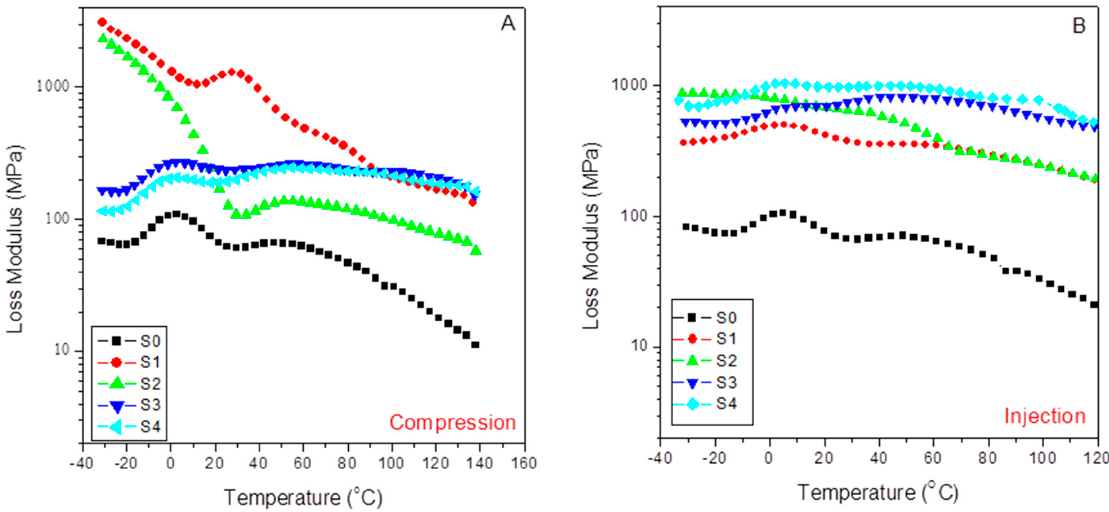
Figure 9. Evolution of the Loss Modulus with temperature for the indicated samples: ( A ) compression-molded; ( B ) injection-molded.